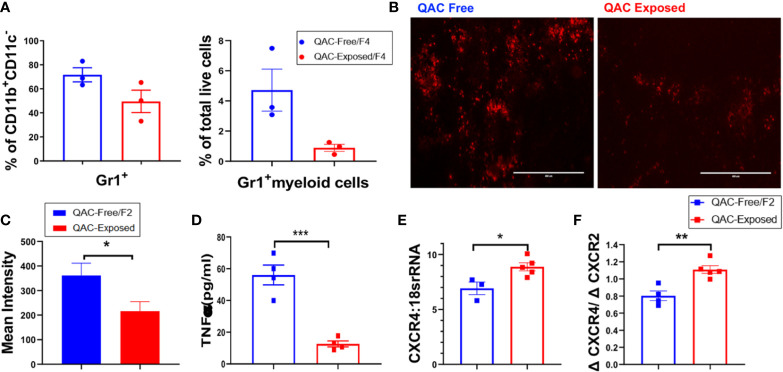
Decreased infiltration of neutrophils into the spleen with ambient exposure to QACs. (A) Splenic Gr-1+ cells as the percentage of CD11b+CD11c− cells (left) and Gr-1+ myeloid cells as the percentage of total leukocytes (right). (B) Representative micrographs of IHC-stained splenic sections showing Ly6G+ neutrophils. (C) Quantification of the micrographs shown as the mean intensity of PE fluorescence. (D) Serum level of TNFα. (E) Transcript level of CXCR4 in BM-enriched neutrophils. (F) Ratio of the transcript levels of CXCR4 and CXCR2. Data are represented as mean ± SEM. *P < 0.05, **P < 0.01, ***P < 0.001.